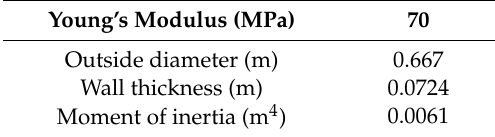
Table 2. Input properties of the model pile used in numerical analysis.